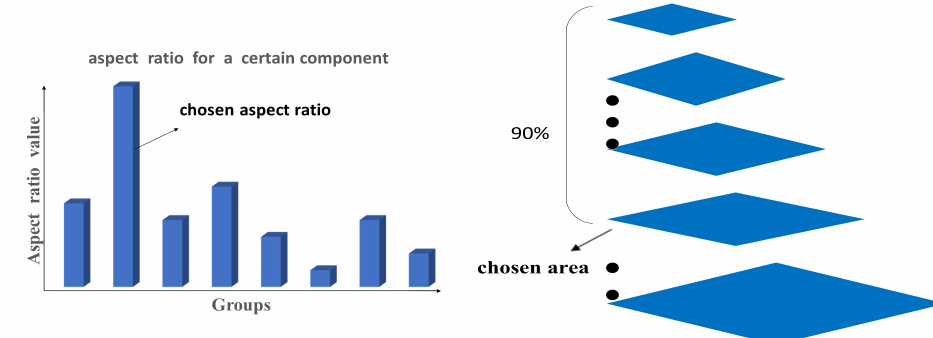
Figure 4. The determination of the aspect and the area.